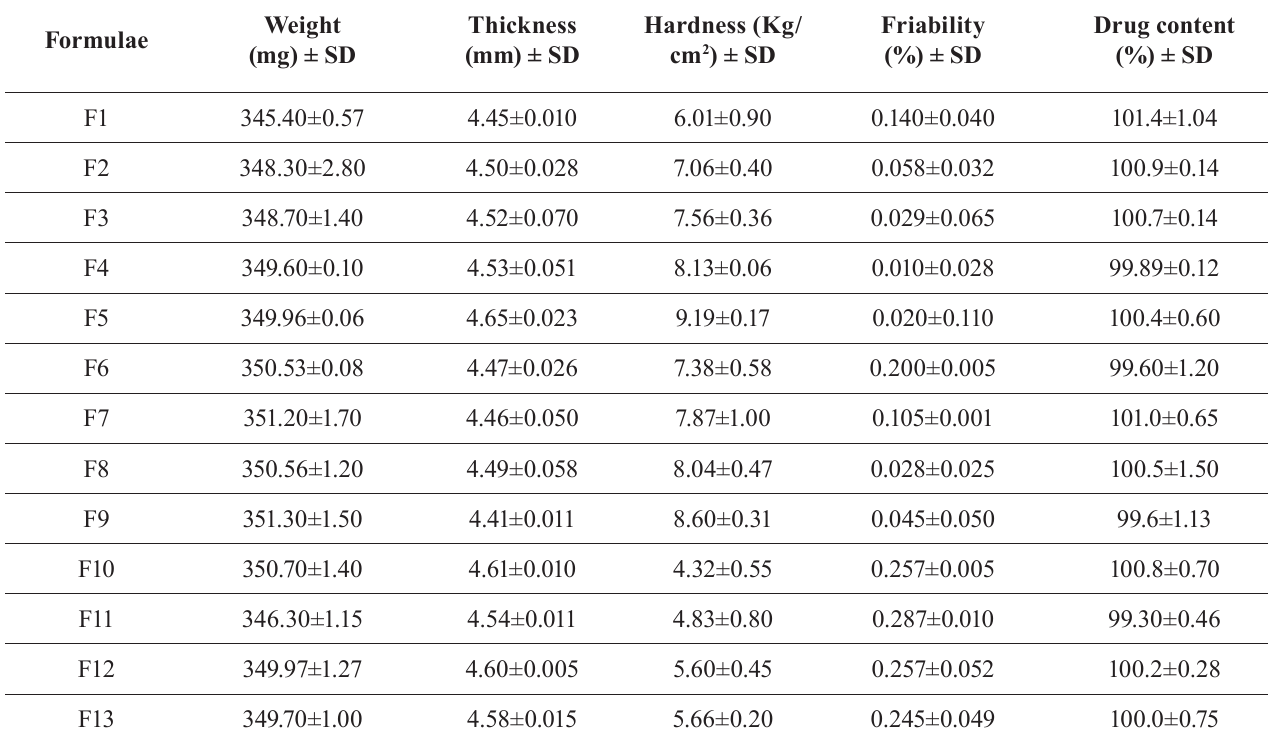
TABLE III - Physical parameters of Eplerenone press-coated tablets